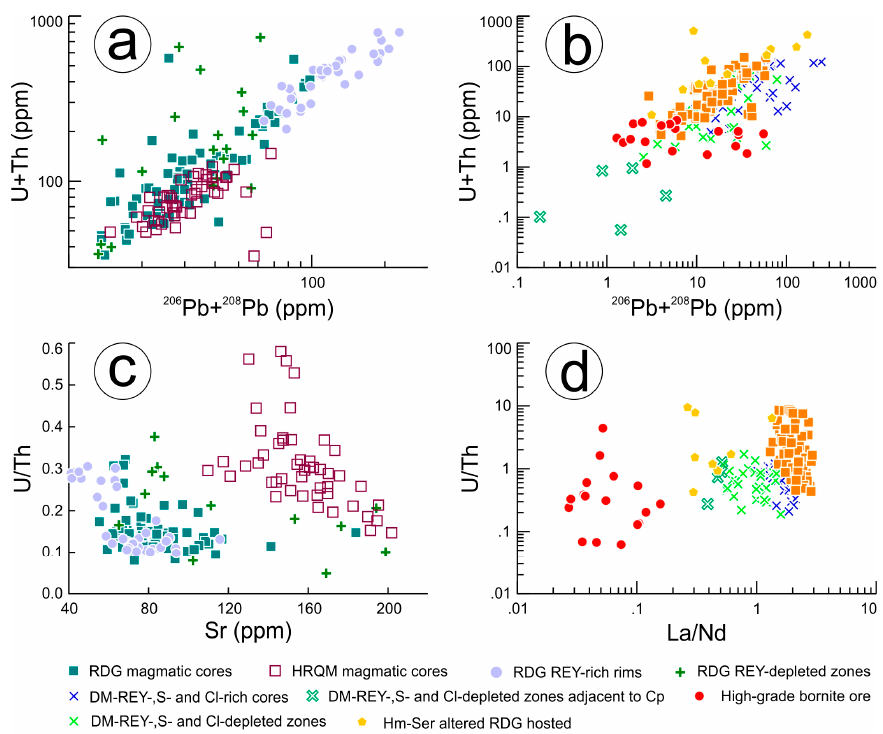
Figure 10. LA-ICP-MS plots of magmatic and hydrothermal apatite: ( a ) log( 206 Pb + 208 Pb ppm) vs. (U + Th) (ppm); ( b ) log( 206 Pb + 208 Pb ppm) vs. log(U + Th ppm); ( a , b ) U and Th concentrations exhibit a strong linear relationship with their lead daughter isotopes; ( c ) Sr (ppm) vs. (U + Th) (ppm); ( d ) La/Nd (ppm) vs. log(U + Th) (ppm).